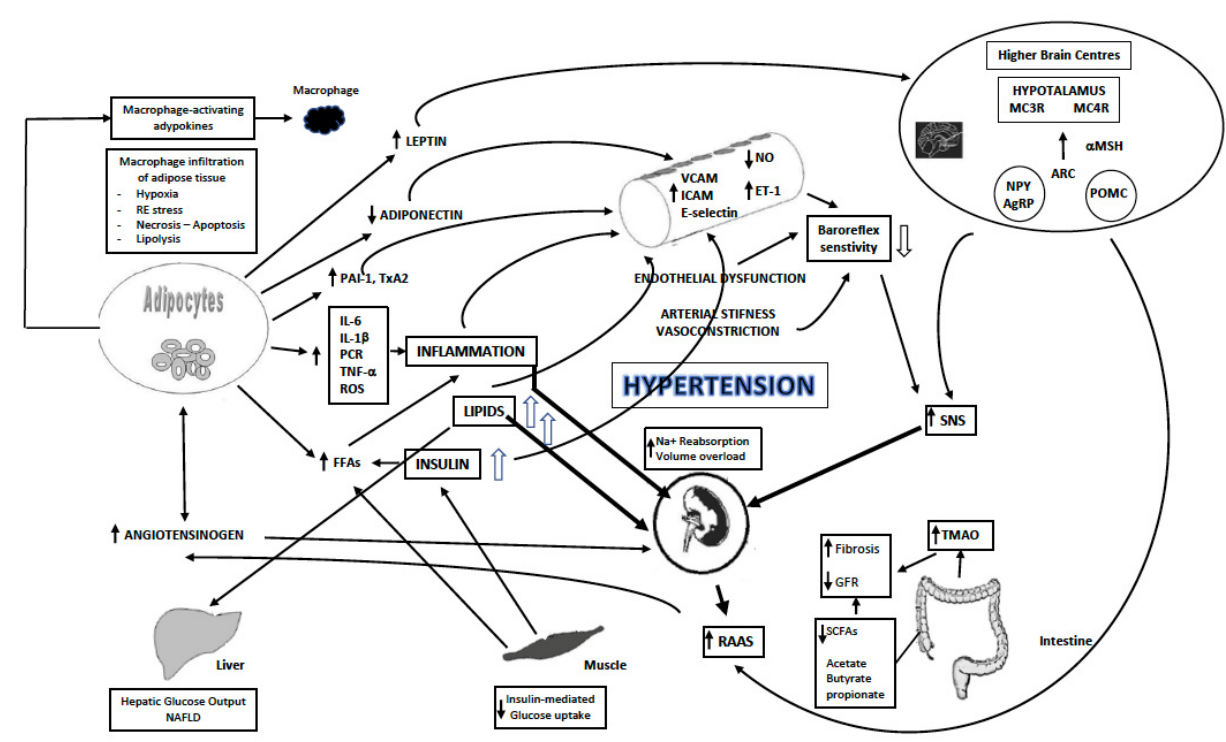
Figure 1. Mechanisms of obesity induced renal damage. Modified from Kotsis V et al., J Hypertens. 2018 Jul; 36(7):1427–1440.